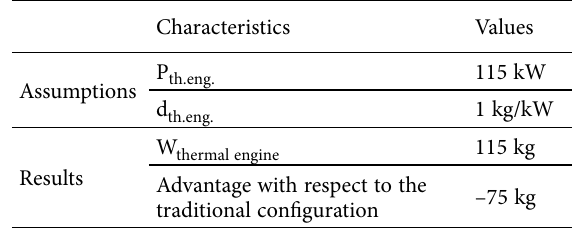
Table 2. Summary of thermal engine sizing